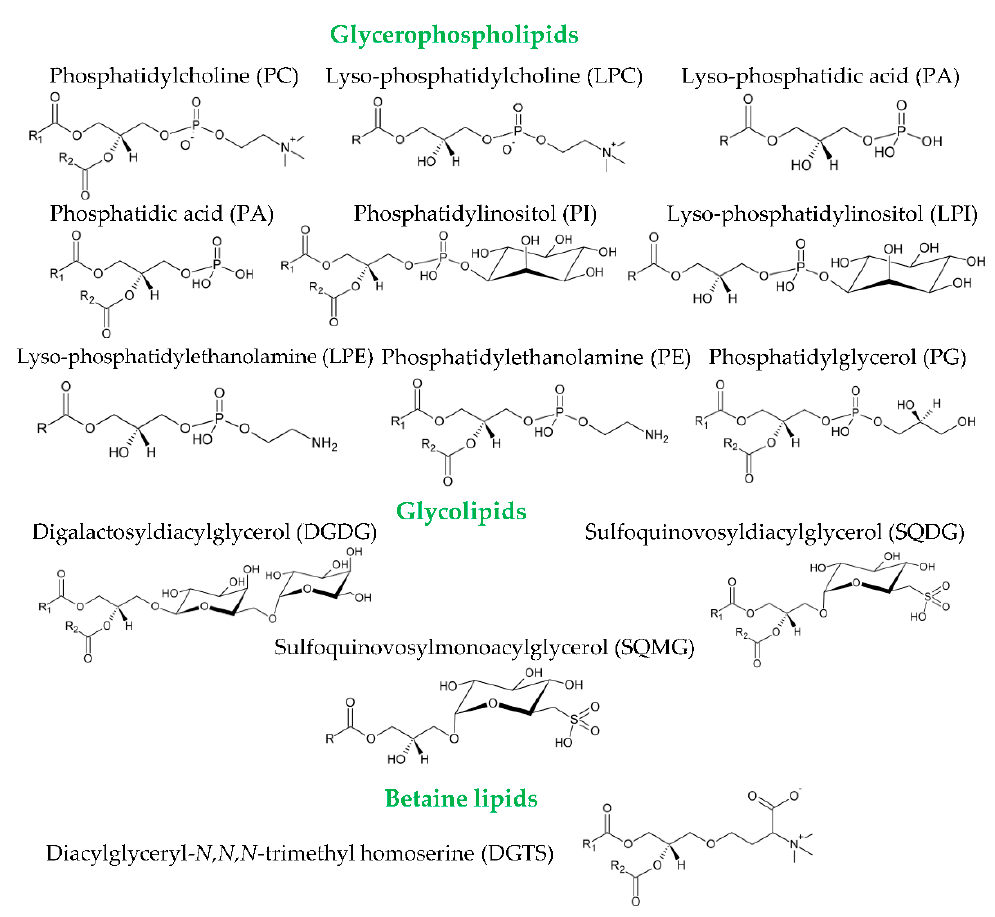
Figure 2. Chemical structures of the classes of glycerophospholipids and glycolipids identified in olives and olive oil. Polar lipids include a broad range of molecules. Phospholipids are divided into two main classes depending on whether they contain glycerol (glycerophospholipids) or a sphingosyl (sphingophospholipids) backbone. Glycerophospholipids, besides the glycerol backbone, contain